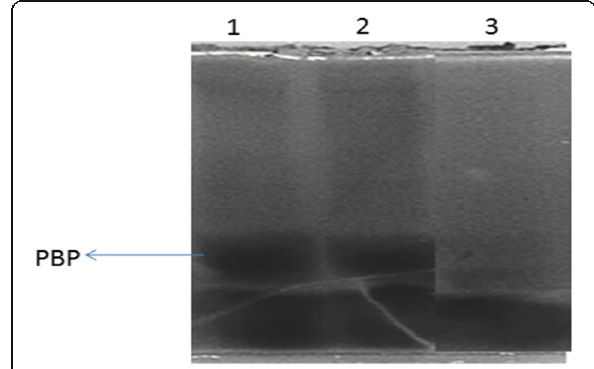
Fig. 2 Purified protein sample on native PAGE analysis. 1 and 2 purified pheromone-binding proteins, 3 negative control